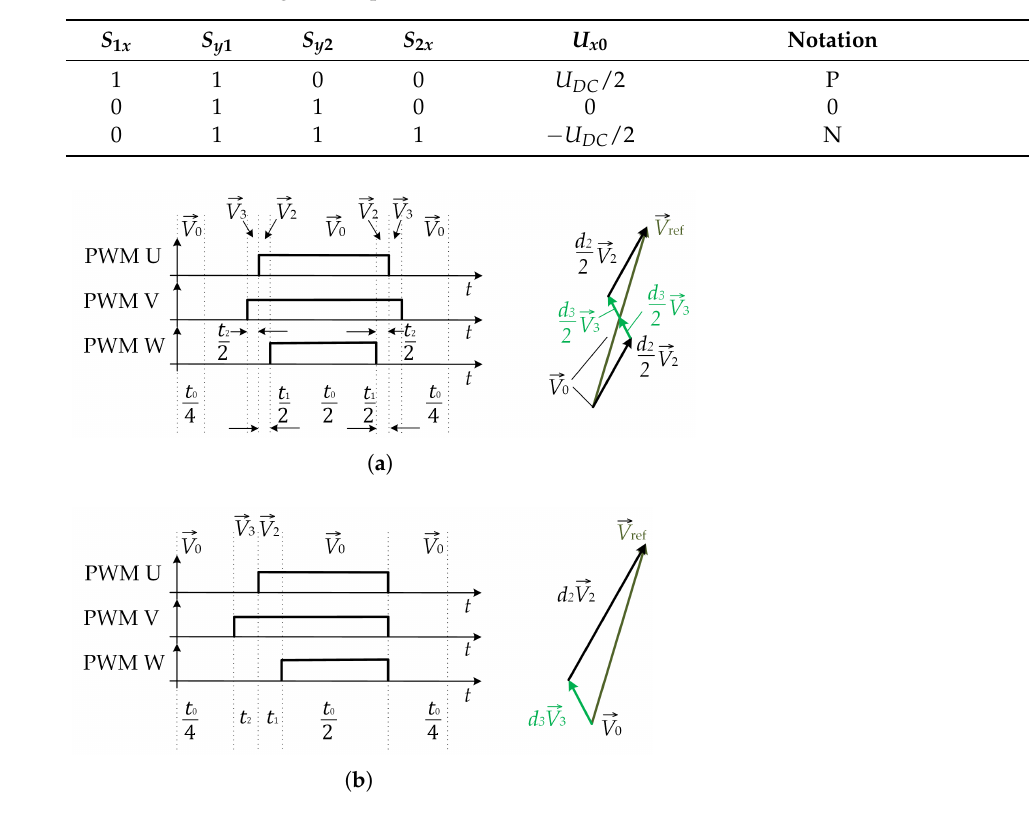
Table 1. The switching state explanation.